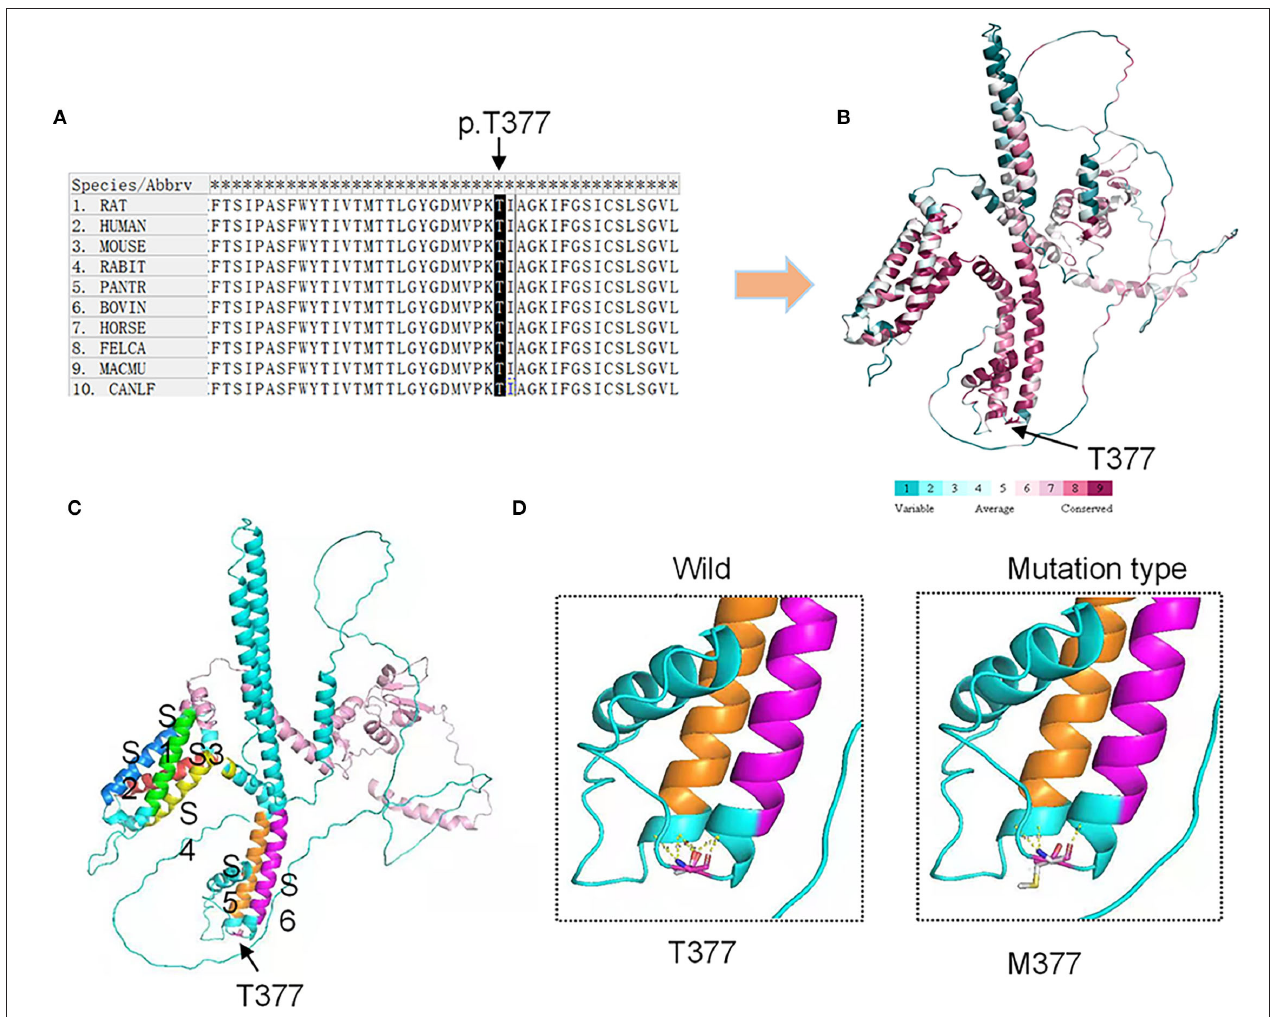
FIGURE 3 | Conservation analysis and protein model prediction: (A) The protein sequence alignment is shown on the left. (B) The protein model showed that it was highly conservative. Highly conservative areas are shown in red color; the higher the score, the darker the color. (C) The protein structure model: A Kv4.3 subunit containing six transmembrane segments (S1–S6). The transmembrane segments are colored in green (S1), blue (S2), red (S3), yellow (S4), orange (S5), and purple (S6). (D) The AlphaFold Protein Structure Database’s Kv4.3 structure models indicate that replacing polar threonine with nonpolar methionine causes an enlargement in the mean volume at residue 377 compared with the wild